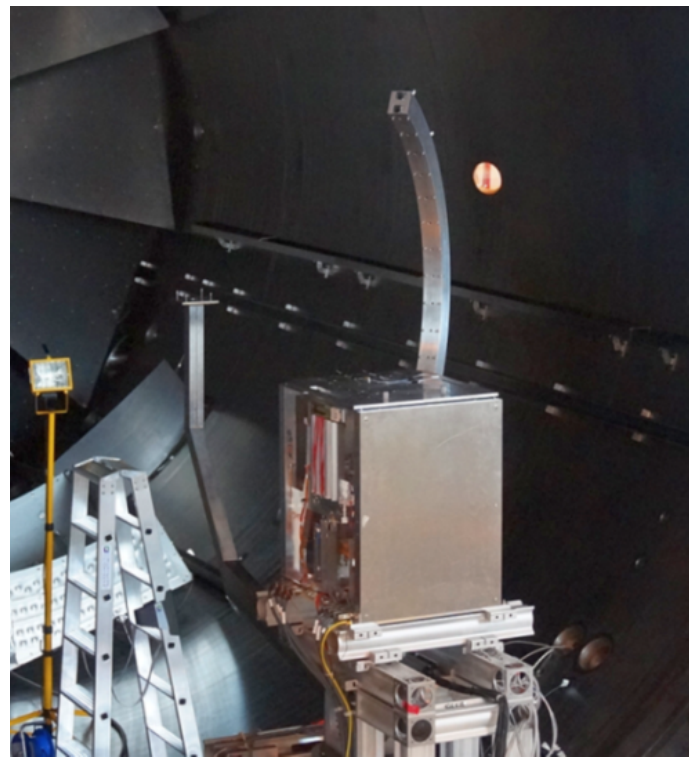
Figure 4: Beam diagnostics systems. On the left the single plane arm, and in the middle of the photo, the multi-sensor arm can be